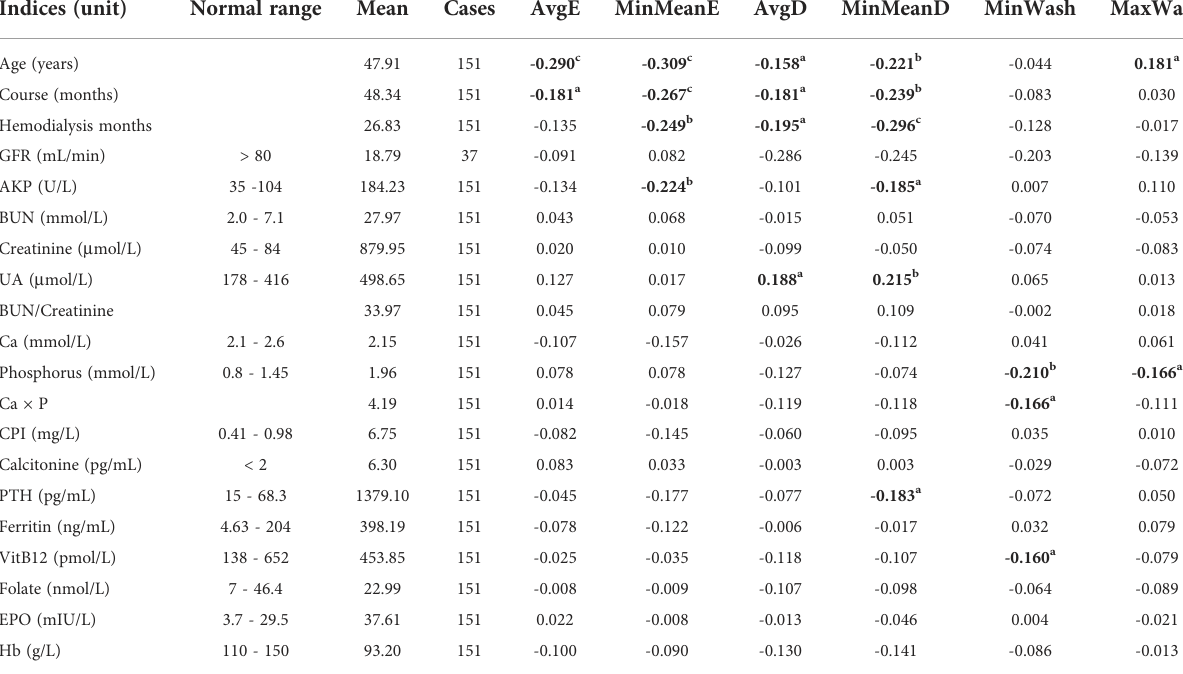
TABLE 1 The relativity of some indices to 99m Tc-MIBI uptake